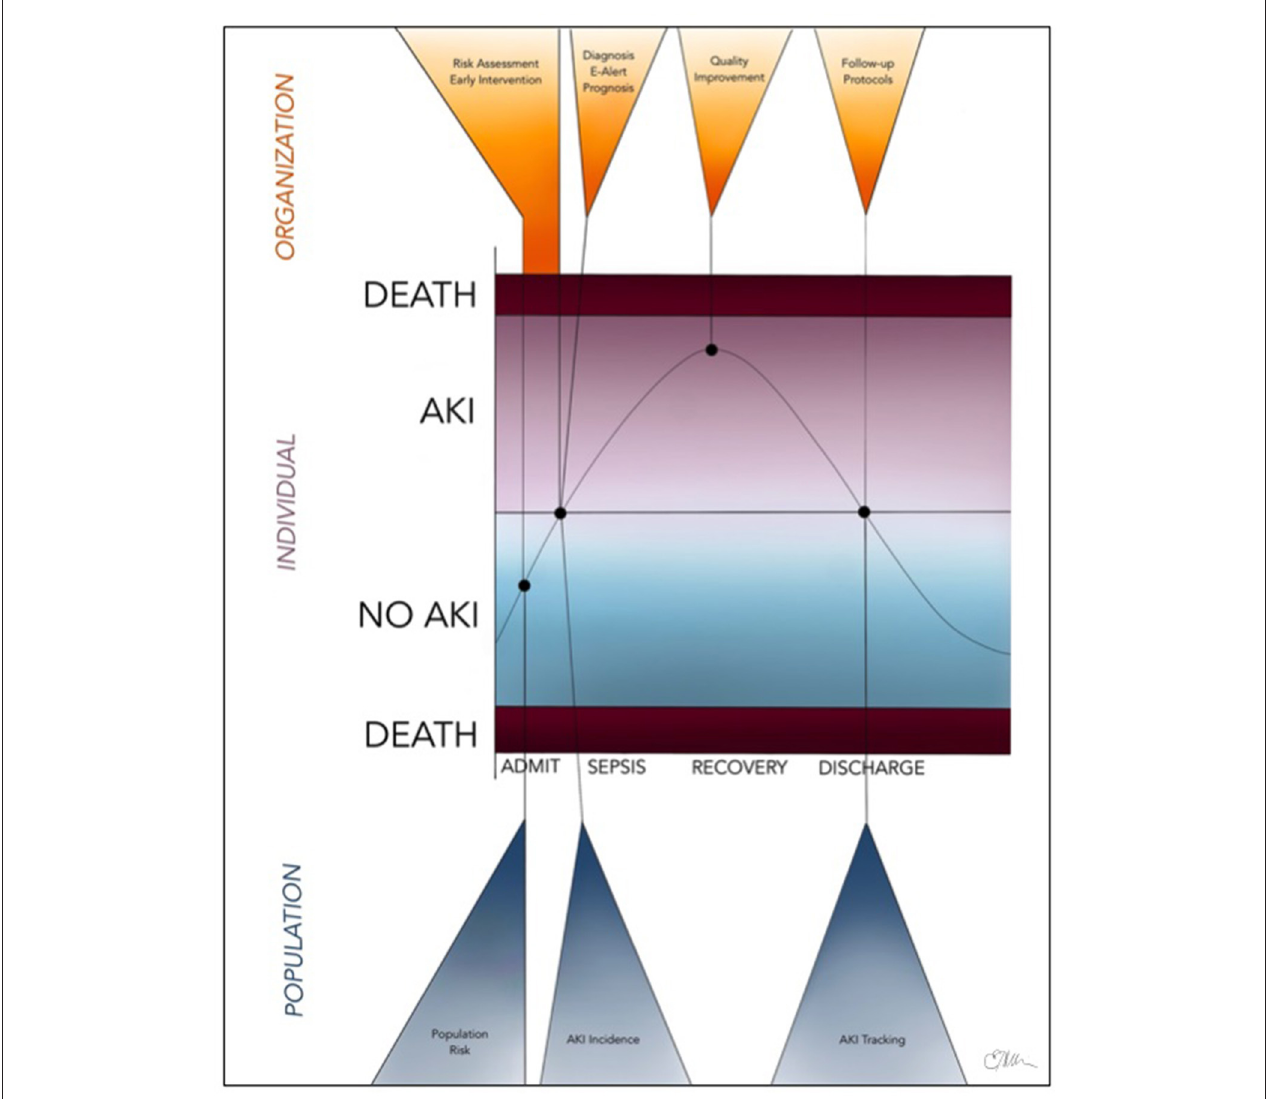
FIGURE 2 | Future, real-time application of “big data” (including administrative health data and electronic medical records) to the identification, management, and monitoring of children and adults with AKI at the individual, organizational, and population